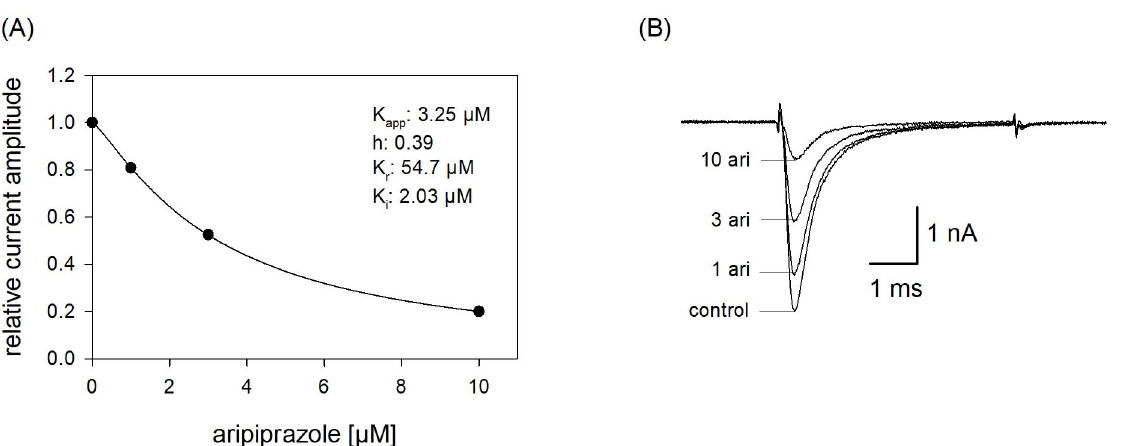
Figure 7. Apparent affinity. ( A ) The graph illustrates relative current amplitudes in the presence of different concentrations of aripiprazole (black circles represent measured normalized current amplitudes, solid line is the result of the fit to Equation (1)). ( B ) Original current traces obtained from channel activations carried out according to the protocol illustrated in Figure 1. The holding potential was set close to half ‐ maximal inactivation (here: − 90 mV). Aripiprazole was preincubated for 10 s before the test pulse was given. Interval between individual sweeps was 10 s. The apparent affinity (K app ) was obtained from a fit of data according to Equation (1). For calculating the affinity to the inactivated state (K i ), Equation (7) was employed, which respects the affinity to the resting state (K r ) and the amount (h) of currently available (not ‐ inactivated) channels. Fit parameters for this cell are shown as insert. Altogether, a K i of 2.14 ± 1.16 μ M was estimated.